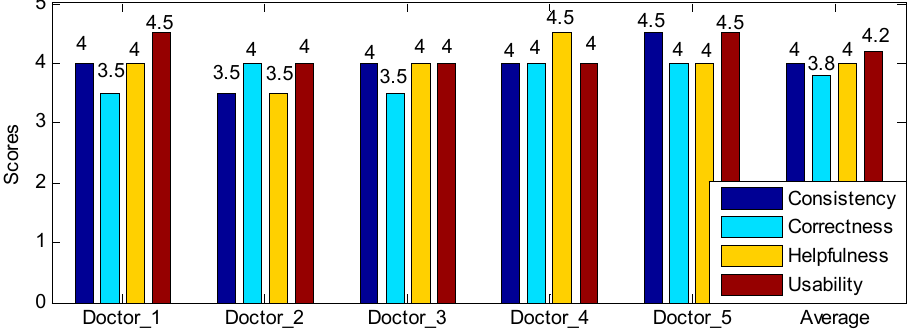
Figure 8. The user study results. The score range is 1 to 5, and the minimum scoring interval is 0.5.